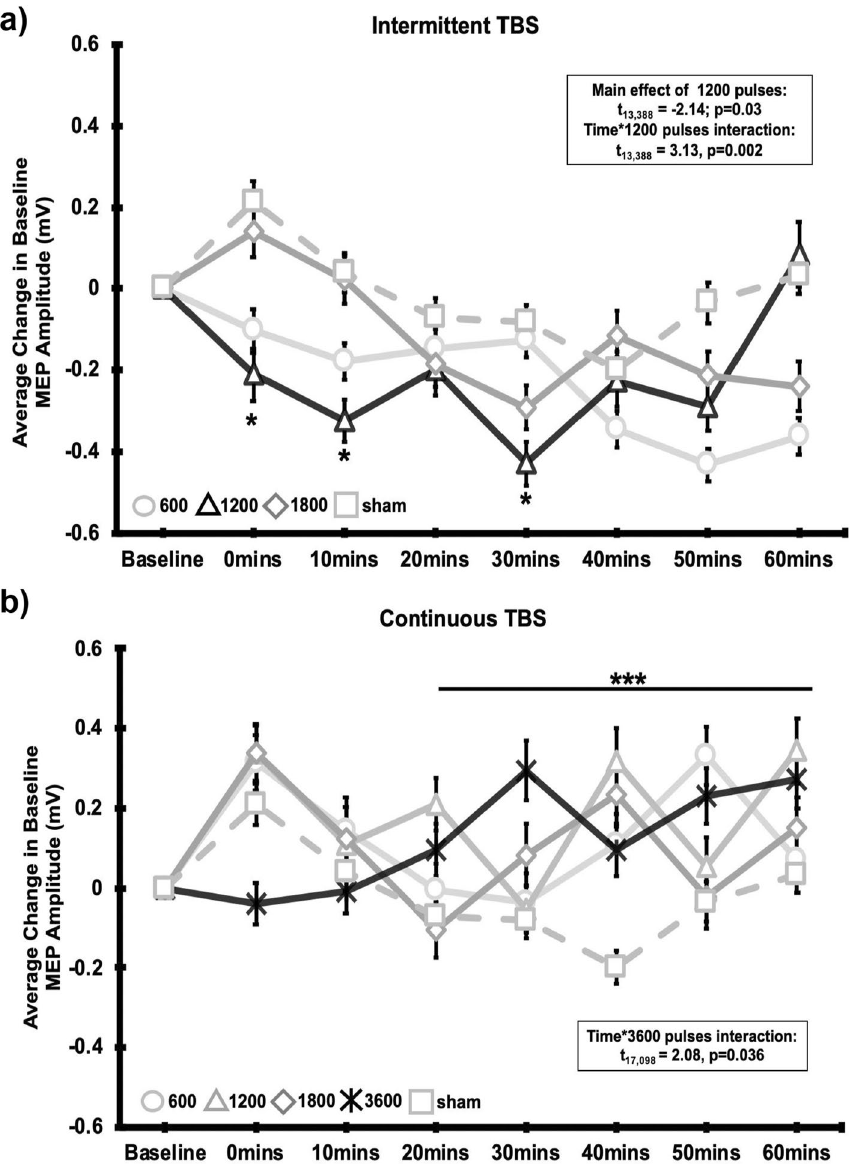
Figure 2. Change in MEP amplitude over time. Line graph showing the ( a ) Effect of iTBS (Experiment 1) doses and sham on average change from baseline MEP over time and ( b ) Effect of cTBS (Experiment 2) doses and sham on average change from baseline MEP over time. Error bars represent ± SEM (standard error of the mean). Average change in MEP for post iTBS and cTBS time points were calculated by subtracting the average baseline MEP amplitude from all MEPs post-treatment. Shapes represent each MEP assessment time point following the 600 pulses (circle), 1200 pulses (triangle), 1800 pulses (diamond), and 3600 pulses (X’s) of iTBS and cTBS. TBS protocols that were significantly different than sham stimulation over time are depicted by black lines. Sham stimulation is represented with a dotted line and squares for each time point. The results of the LME are embedded in the graph